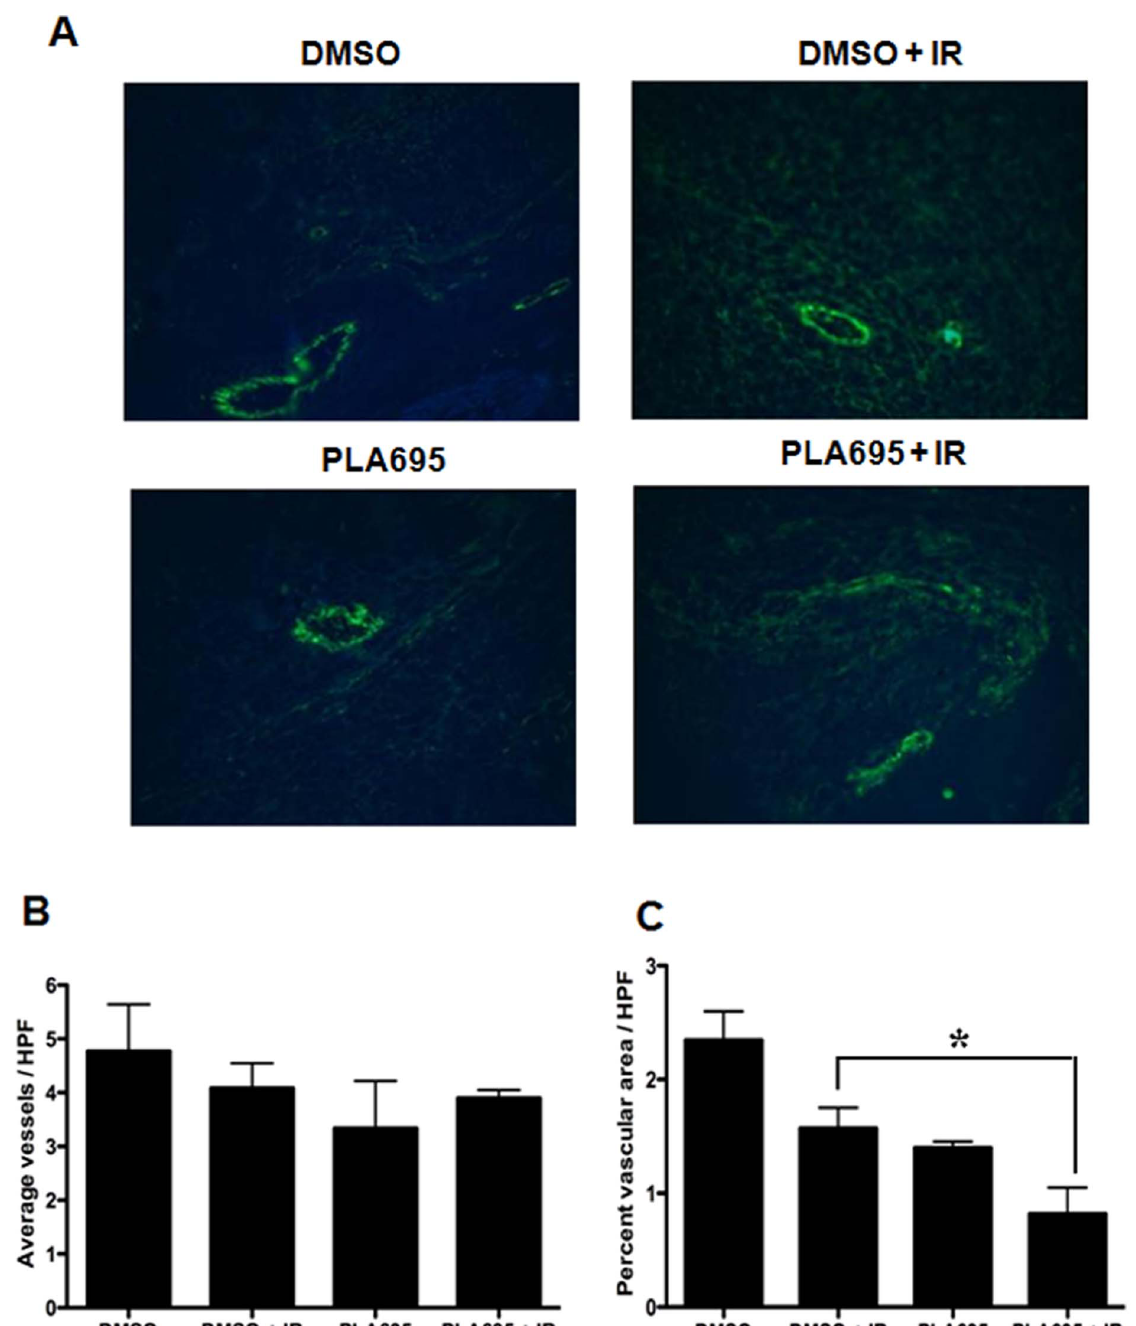
Figure 8. PLA-695 damages vessels in tumors treated with radiation. C57/BL6 mice with LLC tumors received i.p. injections of vehicle or 7.5 mg/kg PLA-695 30 min prior to IR with 2 Gy. Treatment was repeated for 5 consecutive days. Twenty-four hours after the final treatment, tumors were harvested, fixed in 10% formalin, sectioned into 5- m m sections and stained with anti-vWF antibody. Shown are representative micrographs of vWF-stained vessels and bar graphs of the average number of stained vessels per HPF and percent vascular area per HPF with SE from group of 5 mice; *, P , 0.05.